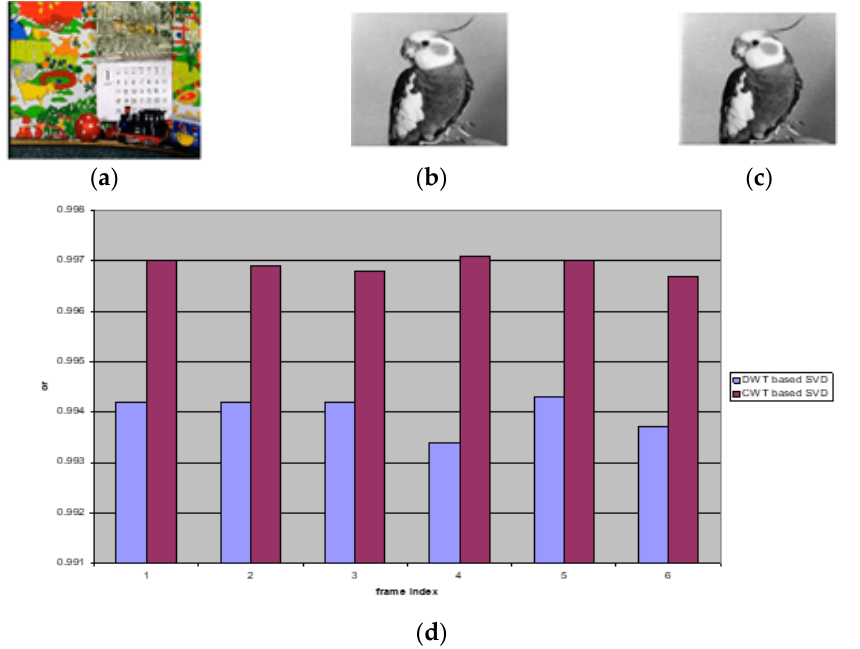
Figure 21. ( a ) The watermarked frame under the histeq attack using the proposed method. ( b ) Extracted watermark from frame 10 of the first video scene in the proposed method. ( c ) Extracted watermark from frame 10 of the first video scene for the DWT-based SVD method. ( d ) Correlation values for the extracted watermarks from each six frames in the first video scene under histeq.